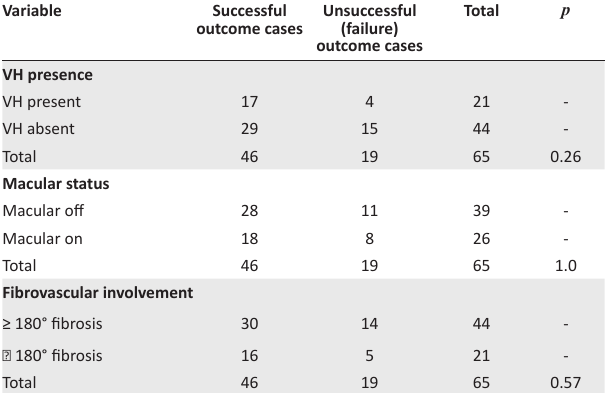
TABLE 1: Factors associated with surgical outcomes.